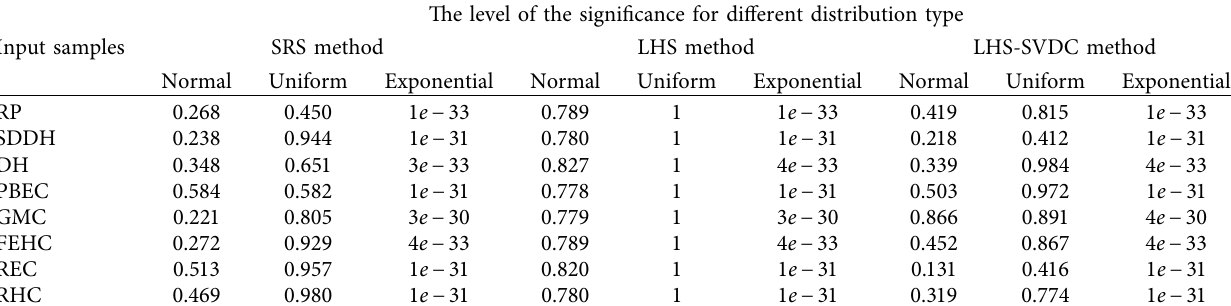
Table 4: K-S test for the samples of the selected 8 inputs with uniform distribution.